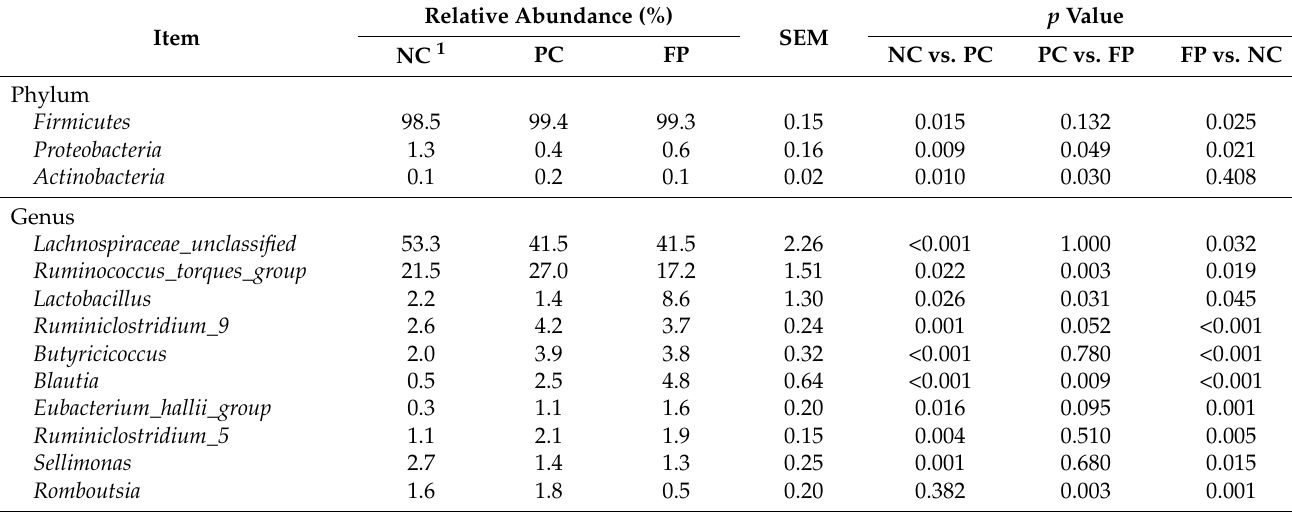
Table 5. Bacterial taxonomic assignment and ranking within the cecal digesta of